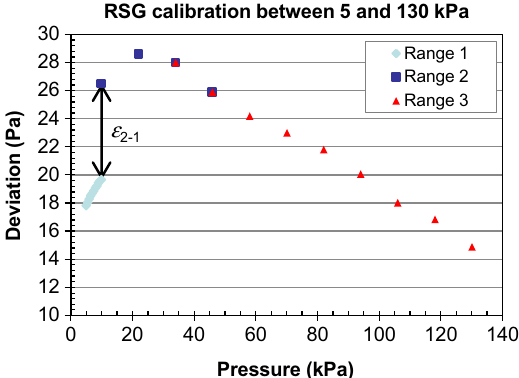
Fig. 9. Deviation of the RSG between 5 and 130 kPa.The whole range is split into three (1 to 3) to model the corresponding calibration functions: range 1 lies from 5 to 10 kPa, range 2 from 10 to 46 kPa and range 3 from 35 to 130kPa.